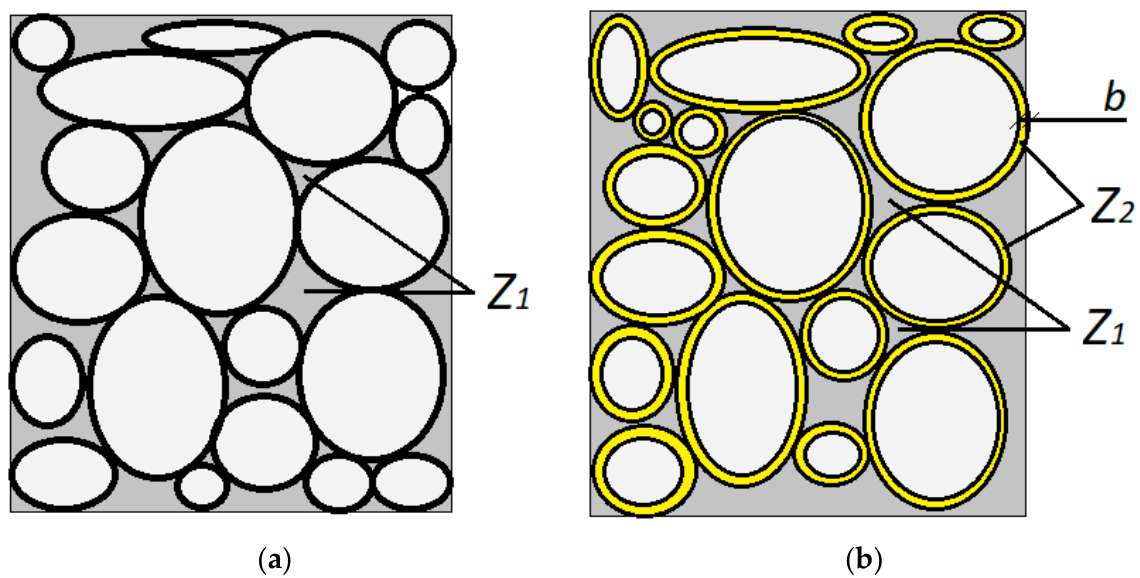
Figure 2. The change in the structure of the aggregate skeleton as a result of coating the grains of the coarse aggregate with paste (the liquid phase). ( a ) normal concrete; ( b ) SCC.